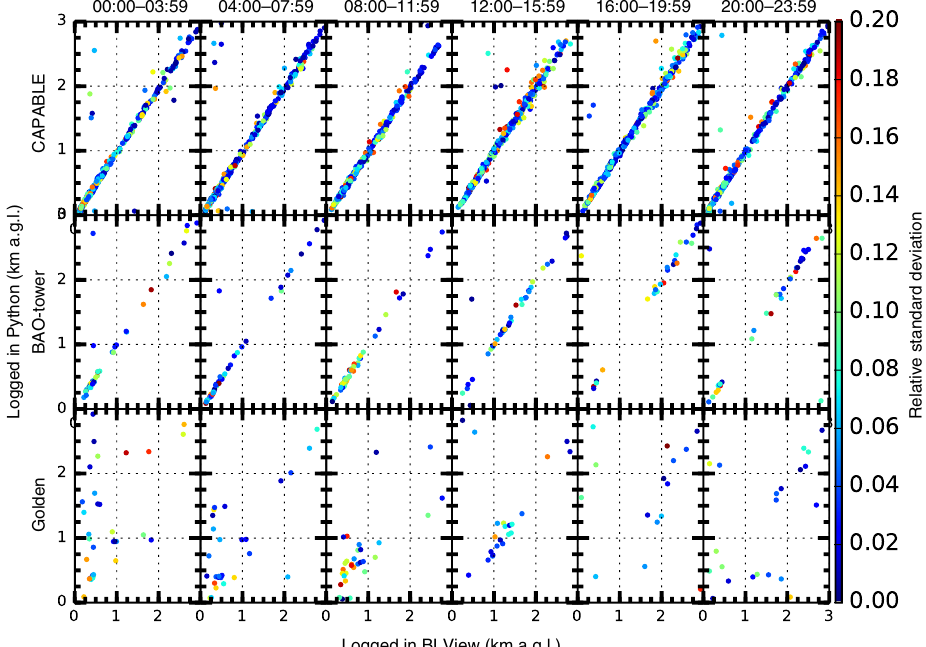
Figure 7. Same data set as in Fig. 6, but with the data resampled to 1h means after application of filtering criteria. Due to the sparseness of the data compared to Fig. 6, there is no need to present data density on the z axis. Here, the z axis represents relative SD to show the relative variability within each 1h block after